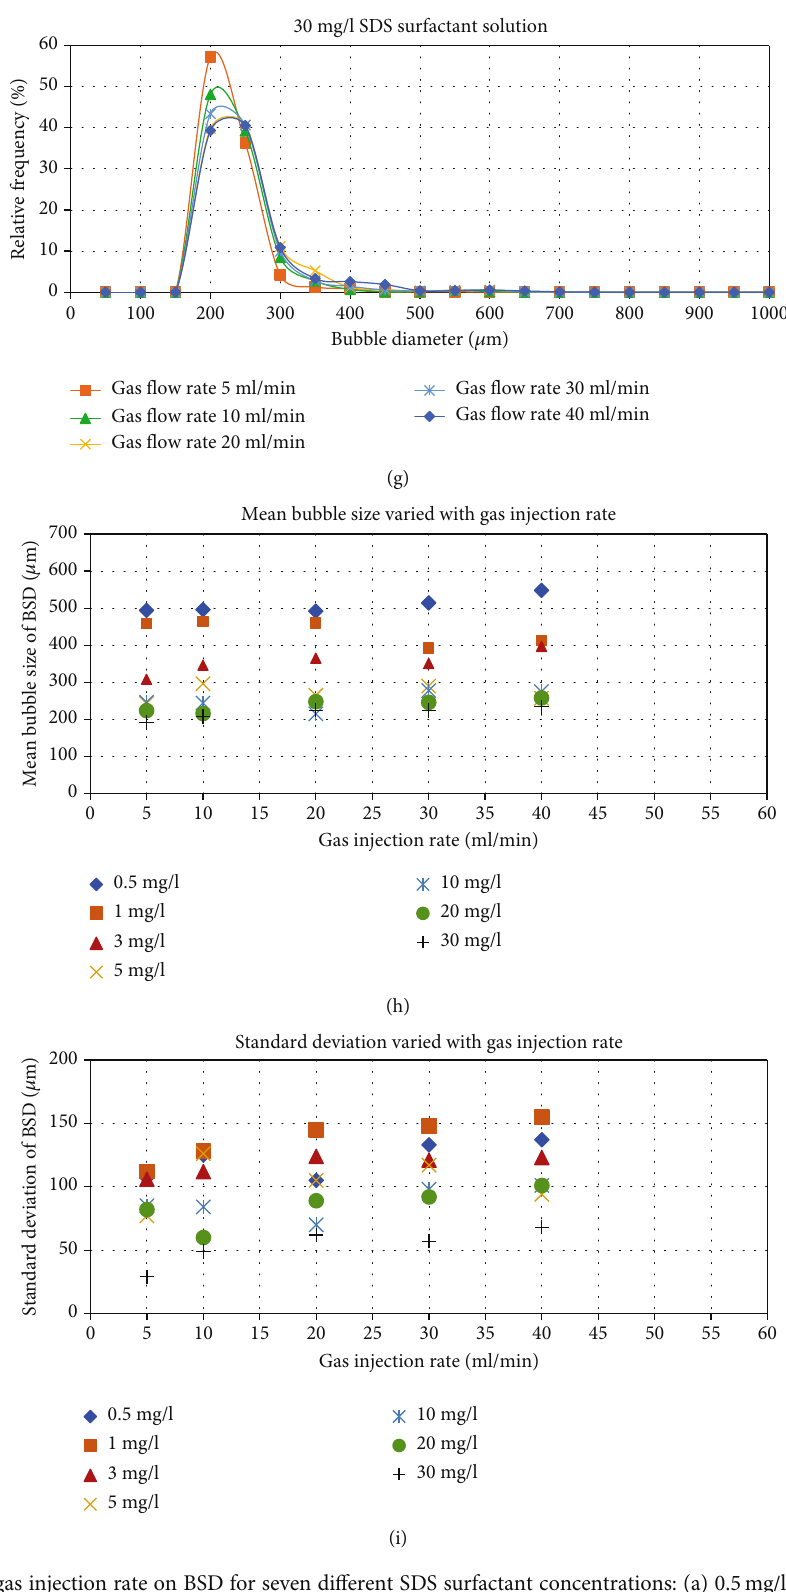
Figure 7: The e ff ects of gas injection rate on BSD for seven di ff erent SDS surfactant concentrations: (a) 0.5mg/l, (b) 1mg/l, (c) 3 mg/l, (d) 5mg/l, (e) 10mg/l, (f) 20 mg/l, and (g) 30 mg/l. (h) The linear mean bubble size of BSD varied with gas injection rates. (i) The STD of BSD varied with gas injection